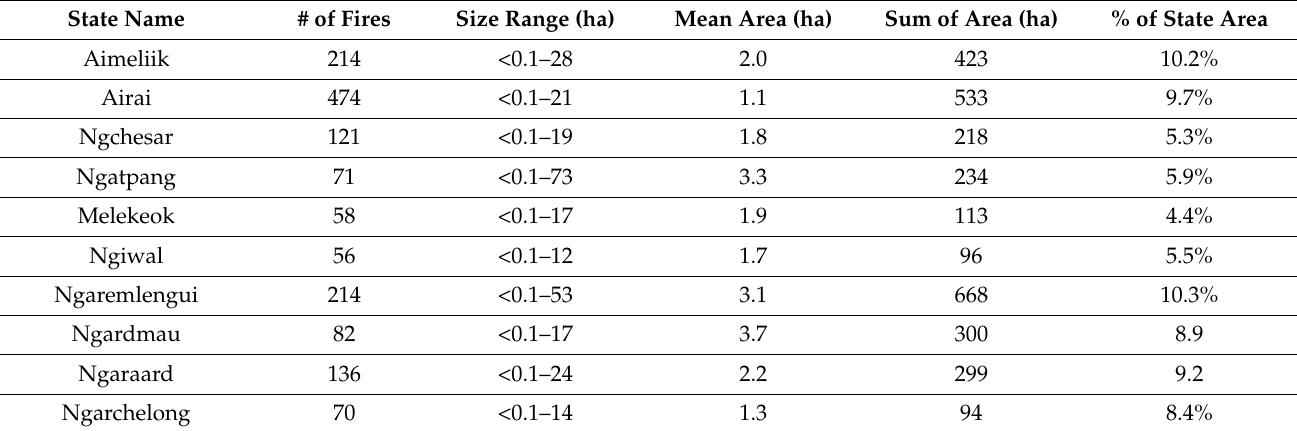
Table 6. Number of wildfires, size range (ha), mean area (ha), sum of burned area (ha), and percentage of state area burned on Babeldaob Island, Palau, from 2012 to 2021 by state.